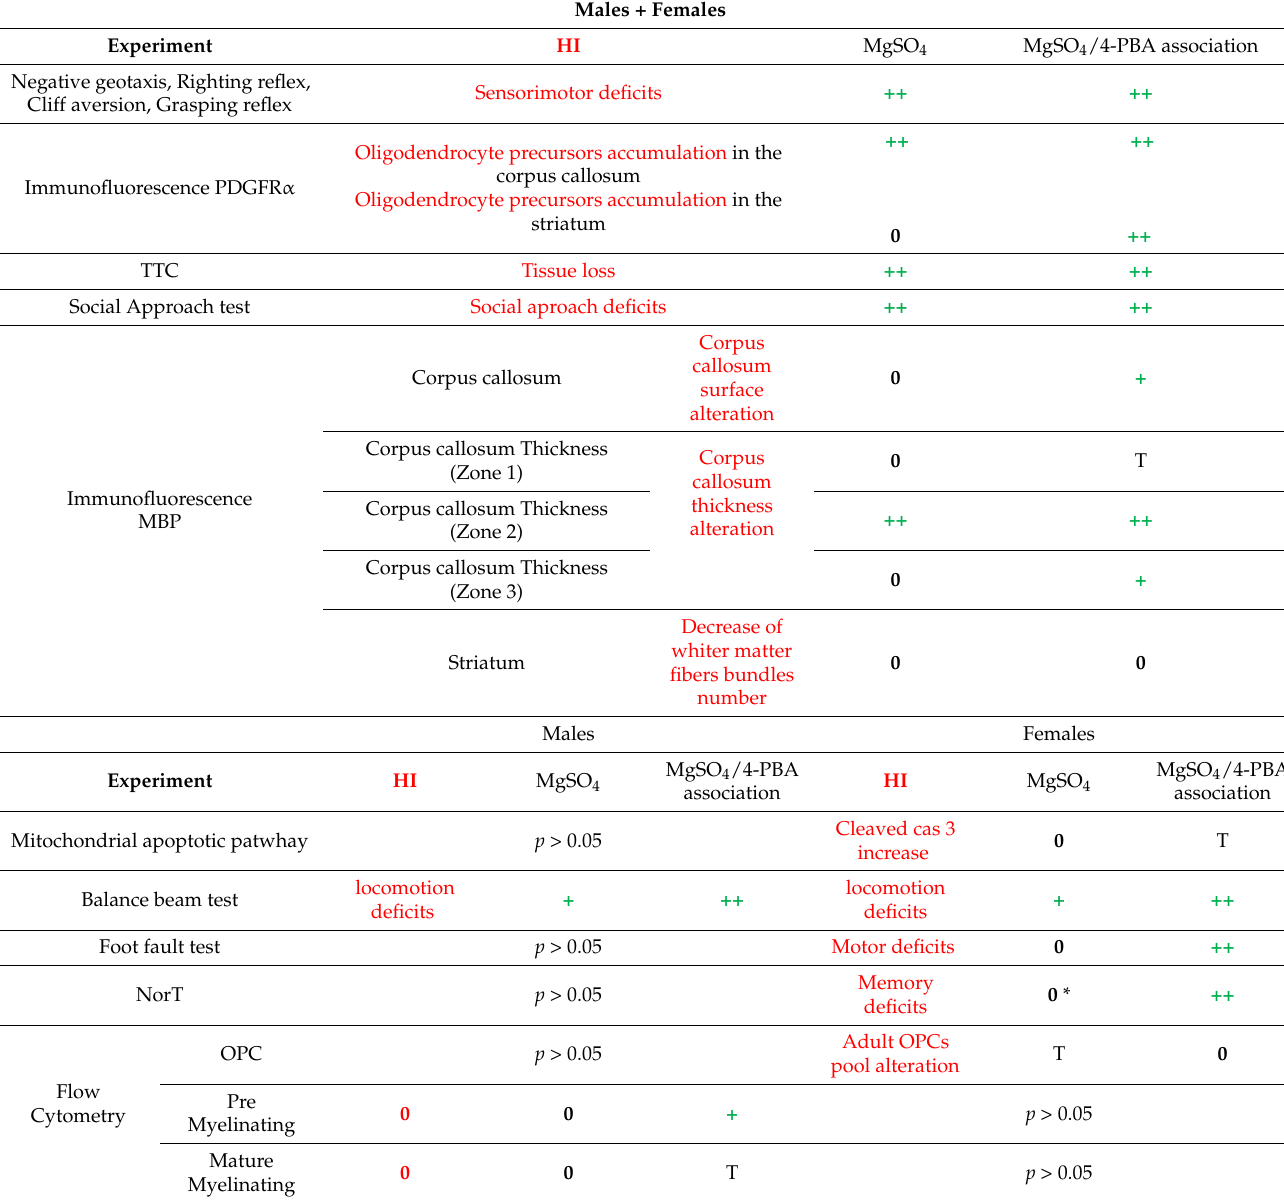
Table 1. Summary of main